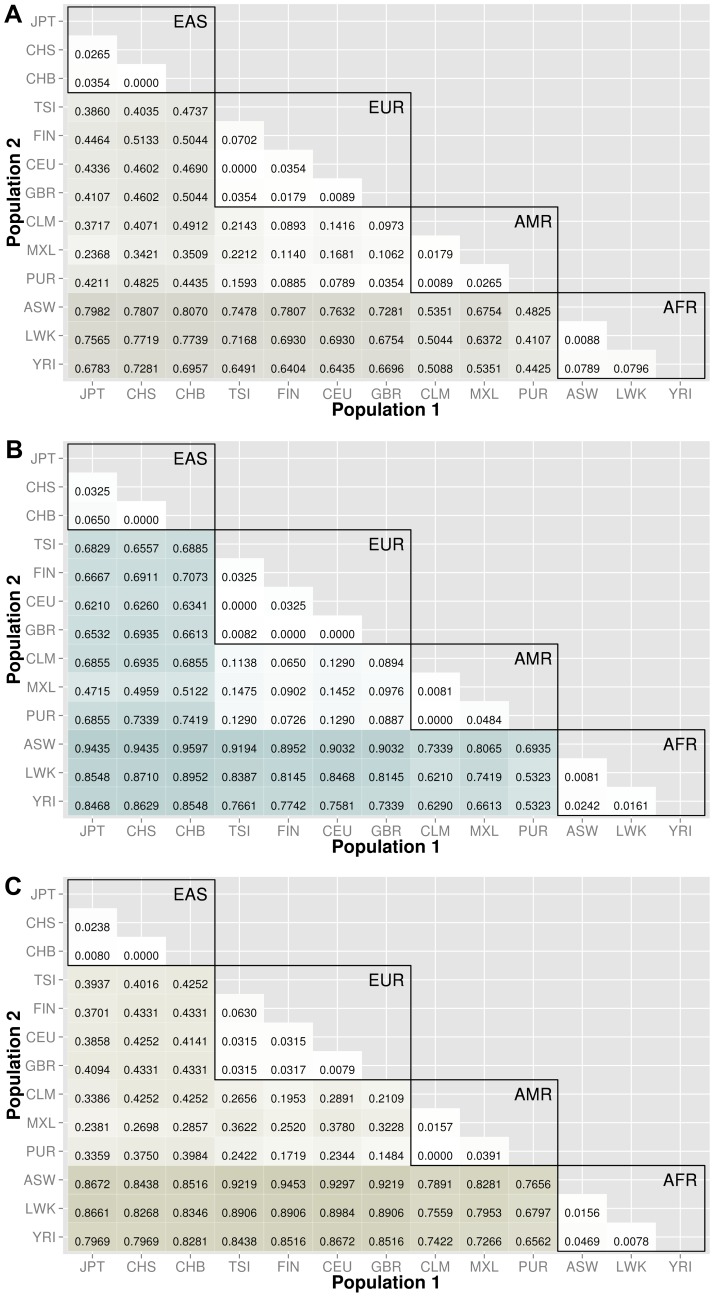
Proportion of significantly different bins in natural selection analysis by region of identification: A) AFR continental group, B) EAS continental group, and C) EUR continental group.The abbreviations for the each population on are on the x and y-axes. The numbers in each block and the color intensity [0,1] indicate the proportion of significant bins (after Bonferroni correction) for the 1000 Genomes populations on each axis, where the darker the color, the higher the proportion of significant bins. In general, the x-axis is organized with African descent populations on the far right and increasing differentiation with regard to low frequency burden towards the left (i.e. populations of Asian descent have the highest proportion of significant bins compared to African descent groups). The regions of natural selection, particularly negative selection, are often accompanied by excess low frequency variants. As world populations evolved, selective forces were often unique and location specific. Therefore, the evolution of low frequency variants compared across world populations can be markers of past selective events. Populations within a continental group are very similar and we see high proportions of statistically significant bins between populations of different continental groups.